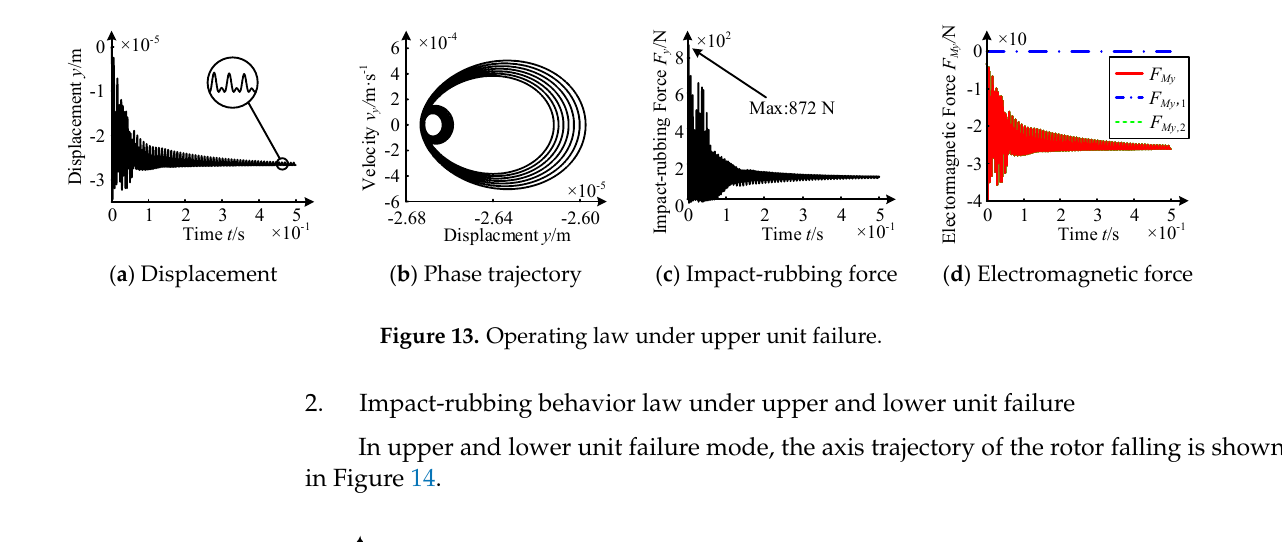
Figure 13. Operating law under upper unit failure.